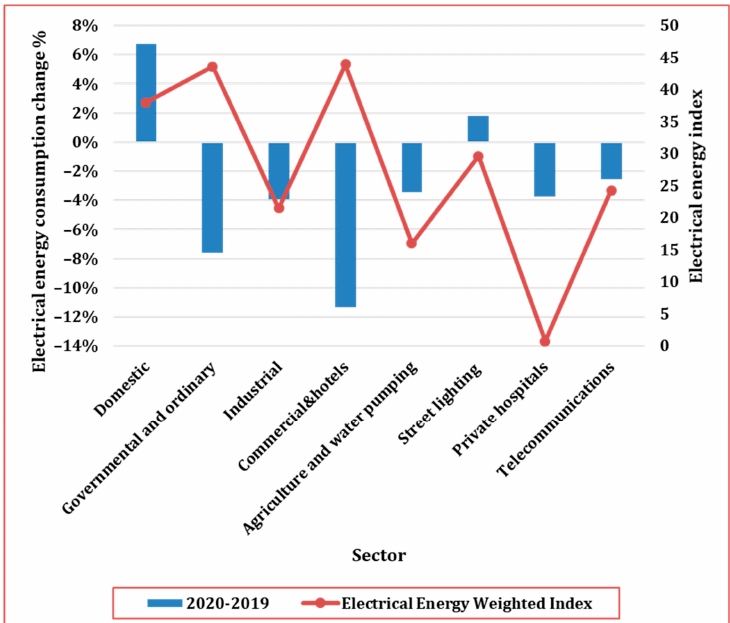
Figure 16. Change in electricity consumption at IDECO’s region between 2019 and 2020 for the dif- ferent sectors with